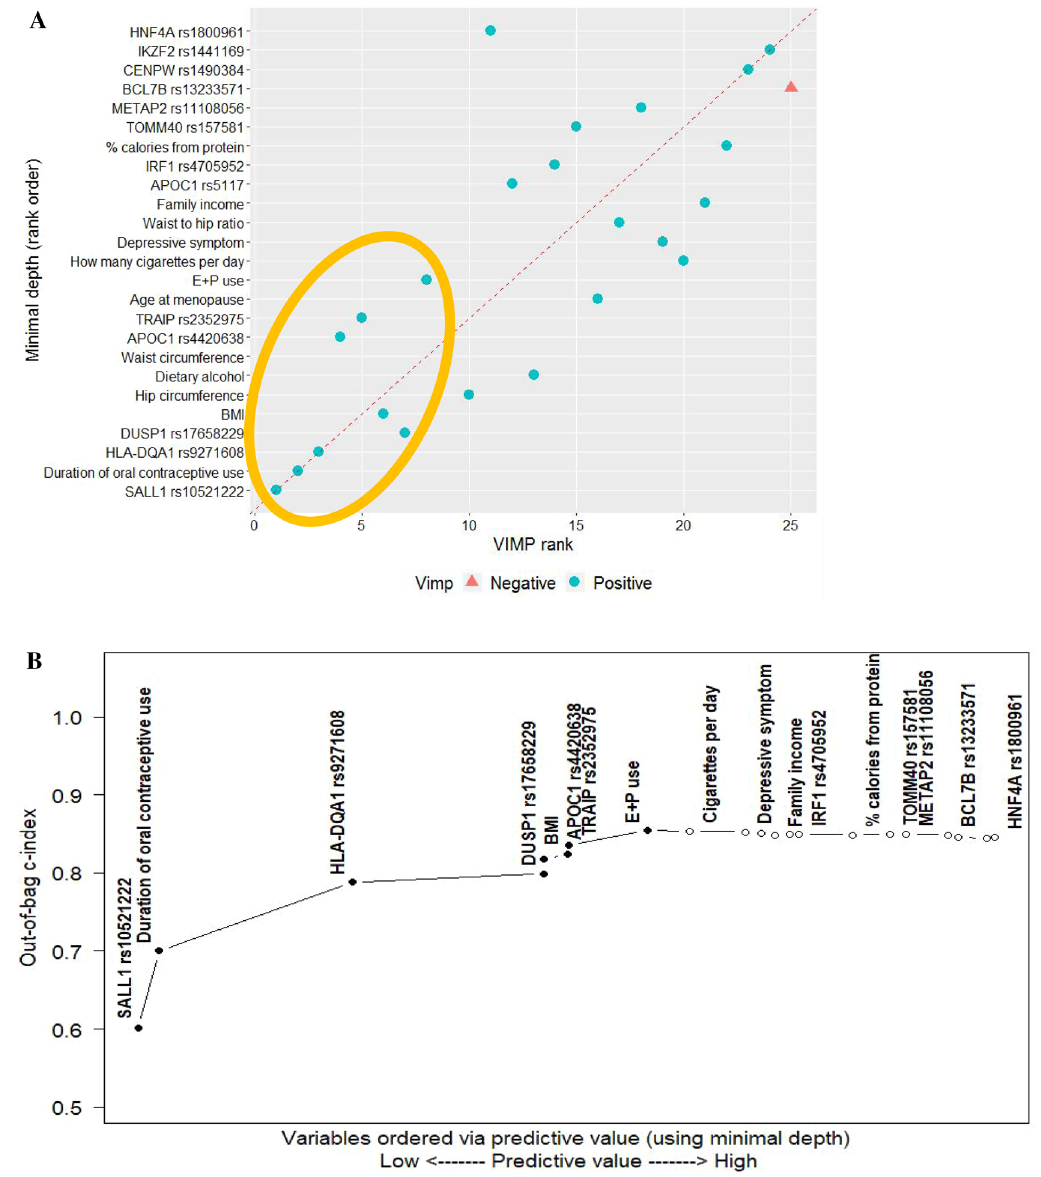
Figure 1. Overall analysis: the second stage of random survival forest (RSF) with 13 single-nucleotide polymorphisms and 12 behavioral factors selected from the first stage of RSF analysis. ( A ) Comparing minimal depth and VIMP rankings. (BMI, body mass index; E + P, exogenous estrogen + progestin; VIMP, variable of importance. 8 variables within the gold ellipse were identified as the most influential predictors). ( B ) Out-of-bag concordance index (c-index) (improvement in the out-of-bag c-index was observed when the top 8 variables [filled black circle] were added to the model, whereas other variables [open circle] did not further improve the accuracy of